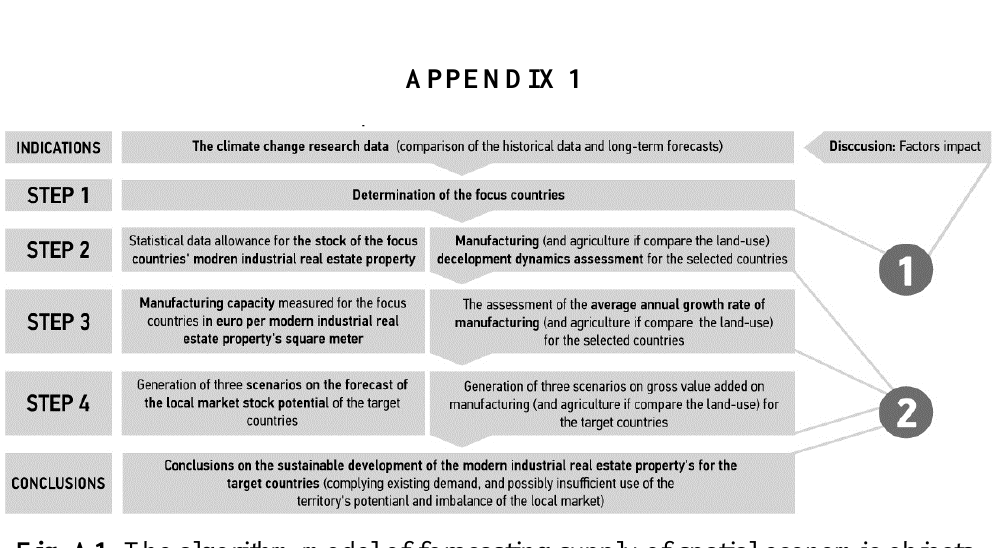
Fig. A1. The algorithm model of forecasting supply of spatial economic objects [developed by